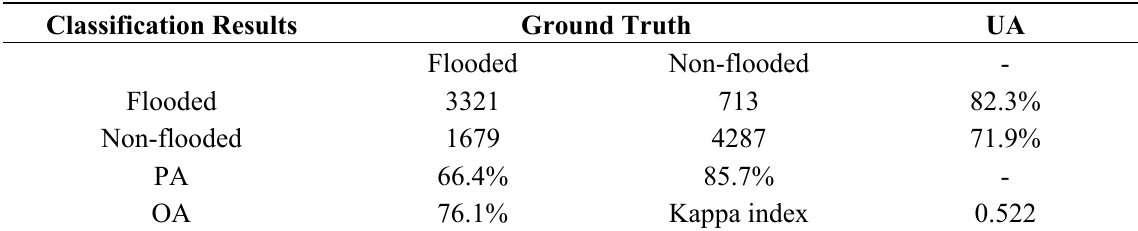
Table 2. Confusion matrix for RGB-only.